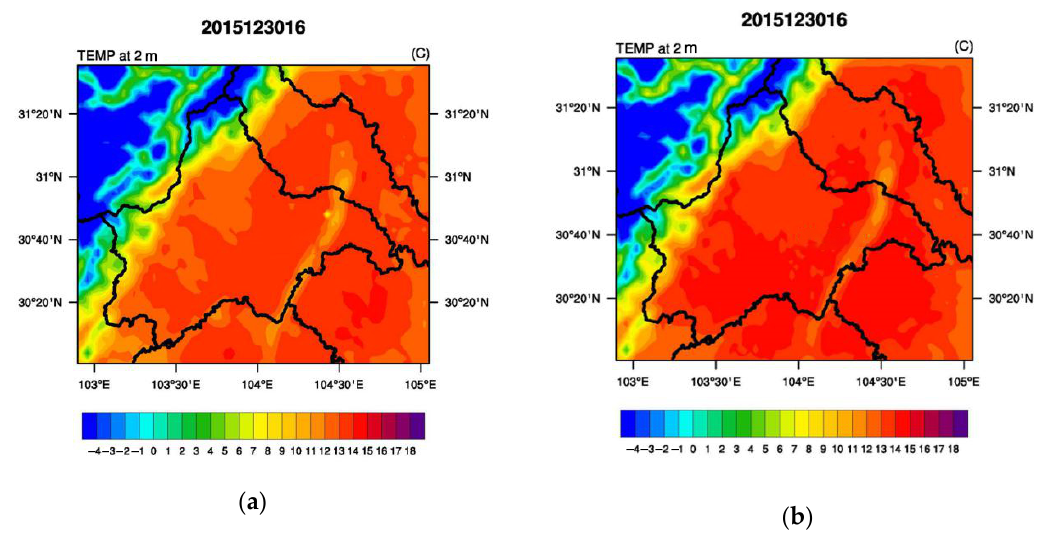
Figure 9. The 2-m temperature map simulated using 1980 ( a ) and 2015 ( b ) land-use data (local time at 16:00 on December 30, 2015).